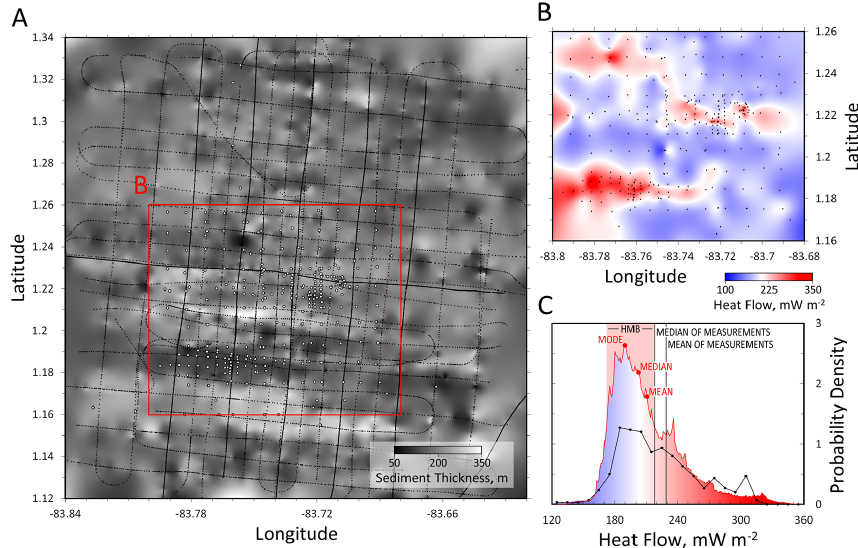
Figure 8. Sediment thickness and heat flow for the Costa Rica Rift. (a) Sediment thickness map constructed from a bicubic spline of seismic reflection profiles (dotted line, where dots are data points; Swift et al., 1998). Open circles are sites of heat flow measurement. (b) Heat flow map constructed from a bicubic spline of measurements (black dots). (c) Non-normalized probability density functions (PDFs) of heat flow. The red PDF is from the bicubic spline in panel (c) , whereas the black line is the PDF using only measurements.